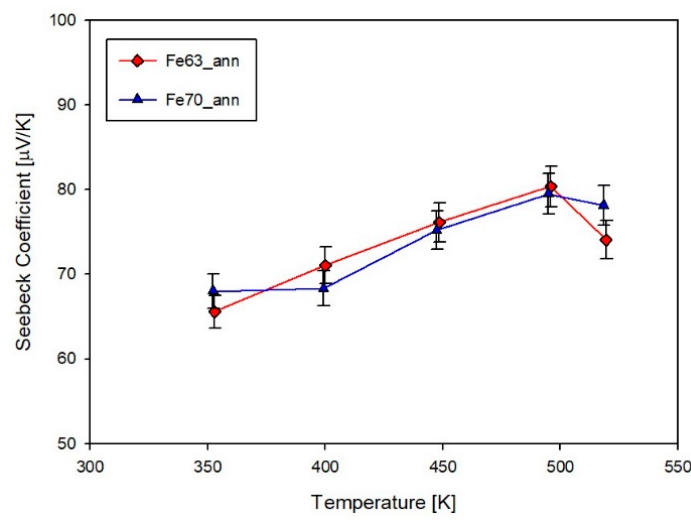
Figure 11. Trend of the Seebeck coefficient as a function of temperature for samples Fe63_ann and Fe70_ann.